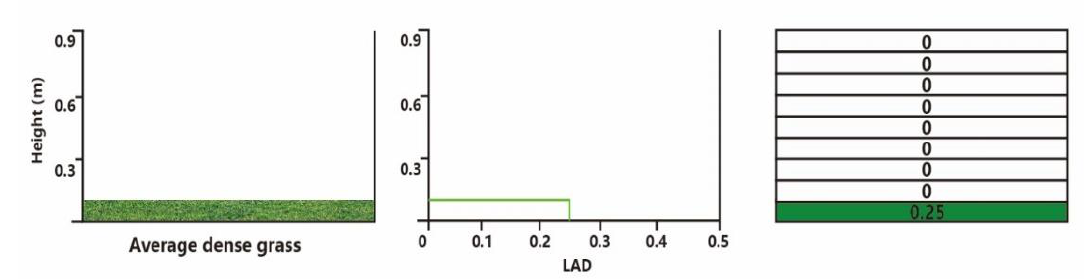
Table 4. The leaf area density (LAD) distribution of the tree [18].